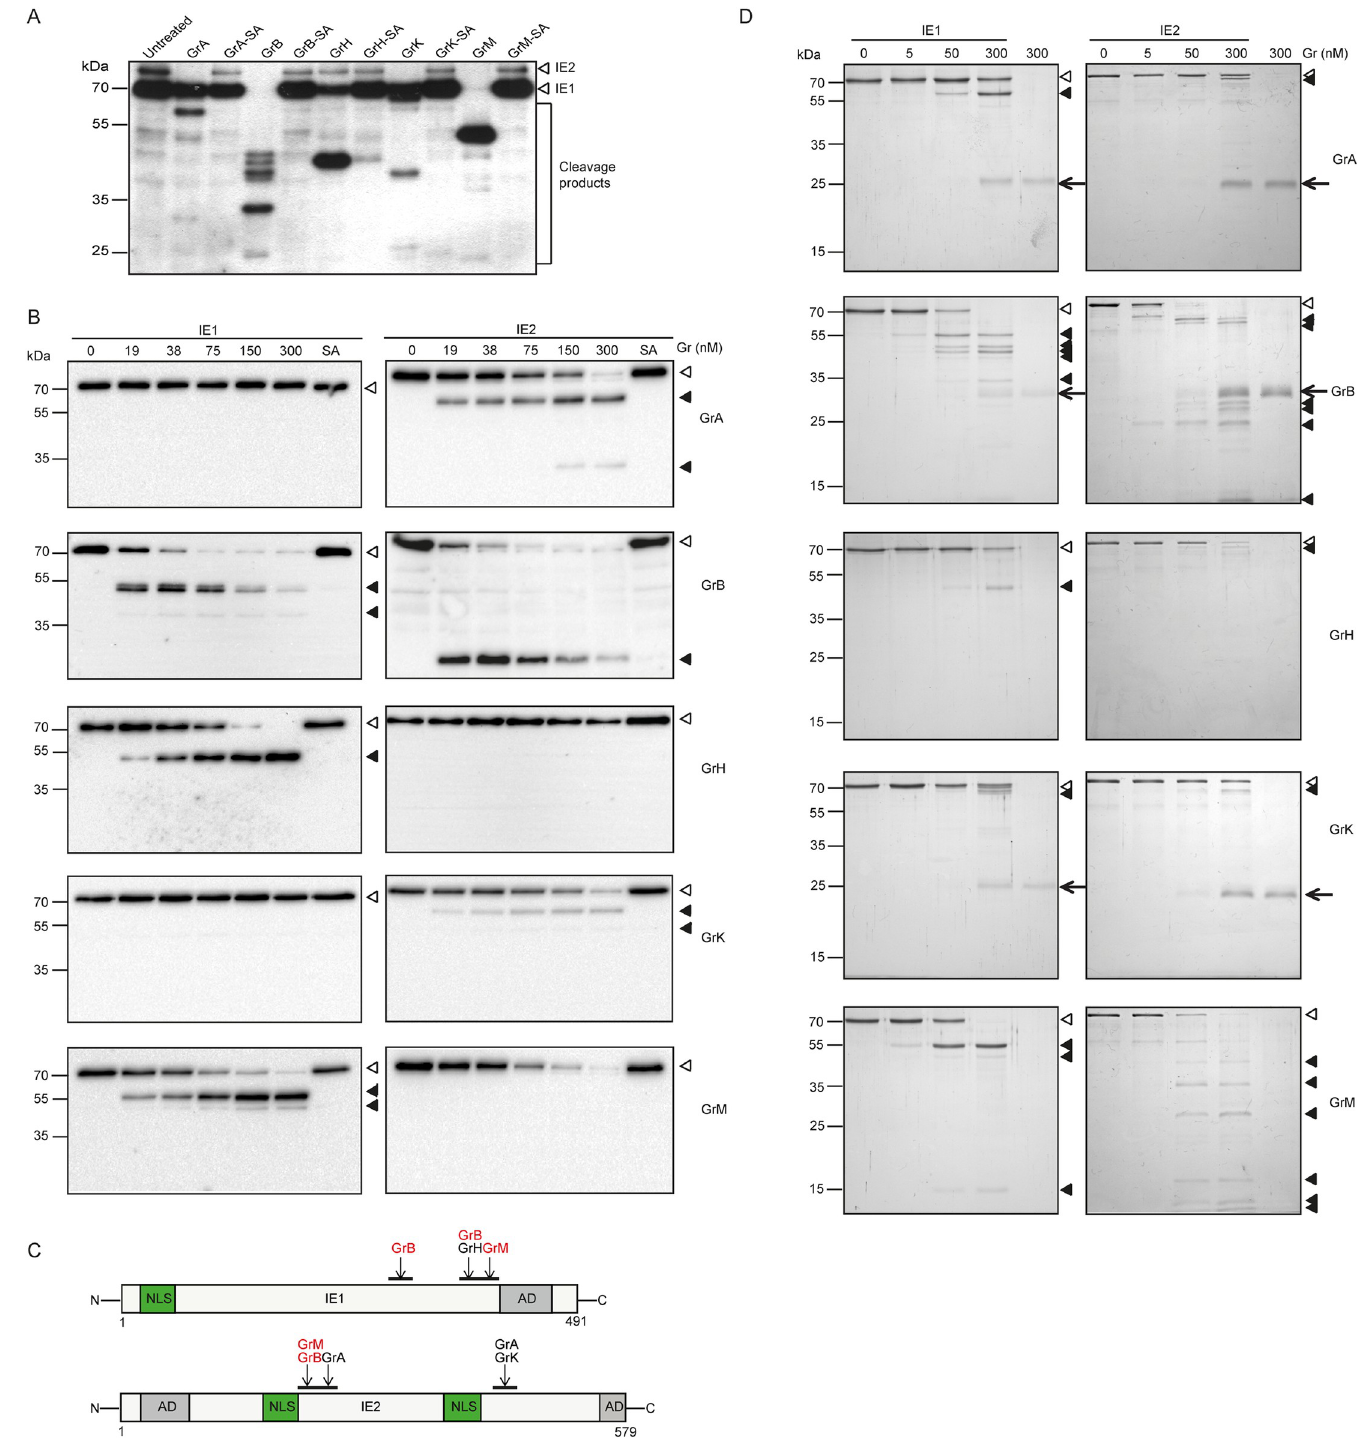
Fig 3. All granzymes directly cleave HCMV IE1 and/or IE2. (A) HFFs were infected with HCMV (AD169) at a MOI of 1.0. 3 days p . i ., nuclear and cytosolic fractions were generated and protein concentrations were measured. Nuclear fractions (0.5 μ g) were incubated with 300 nM purified human granzymes or their corresponding catalytically inactive control SA mutants, or left untreated for 4 h at 37˚C and immunoblotted using an antibody against IE. (B) Cell-free lysates of HA-IE1/2 transfected HeLa cells were incubated with increasing concentrations of purified human granzymes or SA mutants (300 nM) for 3 h at 37˚C and subjected to immunoblotting with an antibody against HA. (C) Schematic overview of putative human granzyme cleavage sites in IE1 and IE2 (NLS, nuclear localization signal; AD, activation domain).